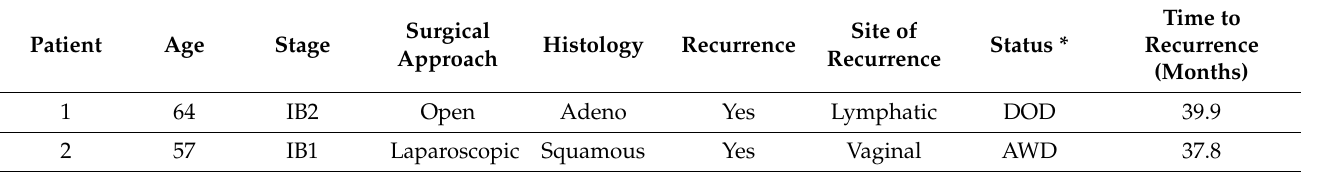
Table 3. Recurrence